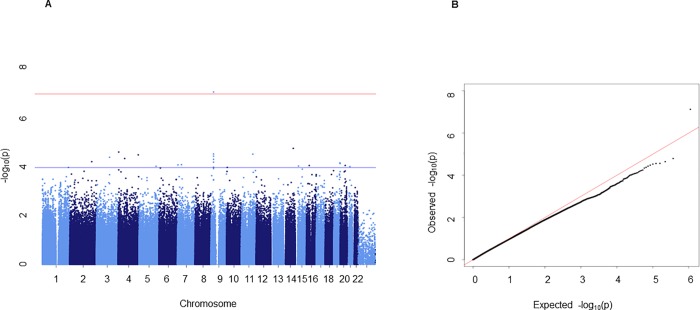
Manhattan plot of genome-wide association signals with severe coronary artery calcification (A) and a quantile–quantile plot (B) in the discovery set. In the Manhattan plot, the x-axis represents the SNP markers on each chromosome. The y-axis shows the -log10 p-value (logistic regression). The red horizontal line represents the genome-wide significance threshold p = 9.078E-08, and the blue horizontal line represents the genome-wide suggestiveness threshold p = 1E-04.